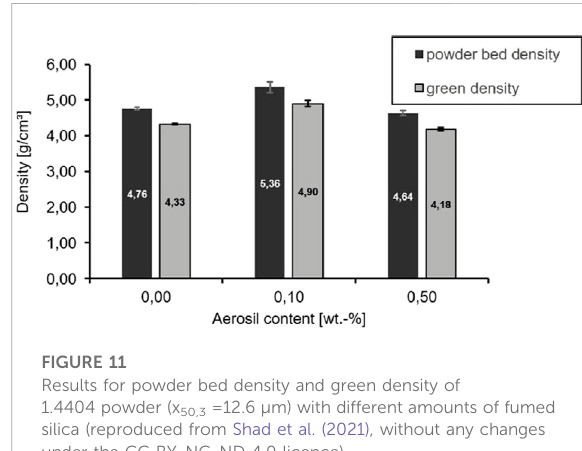
FIGURE 11 Results for powder bed density and green density of 1.4404 powder (x 50,3 =12.6 µm) with different amounts of fumed silica (reproduced from Shad et al. (2021), without any changes under the CC BY-NC-ND 4.0 licence).